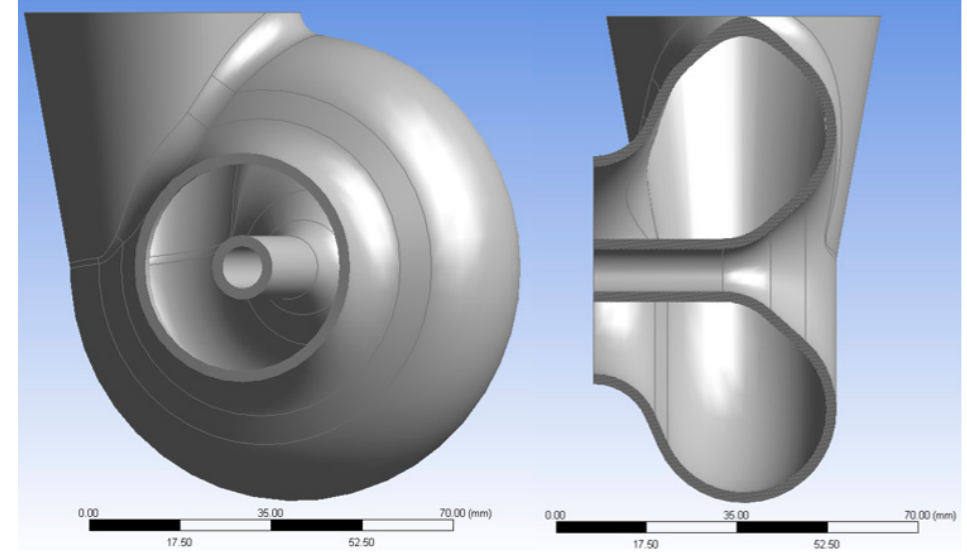
Figure 13. 3D model of the optimised volute.